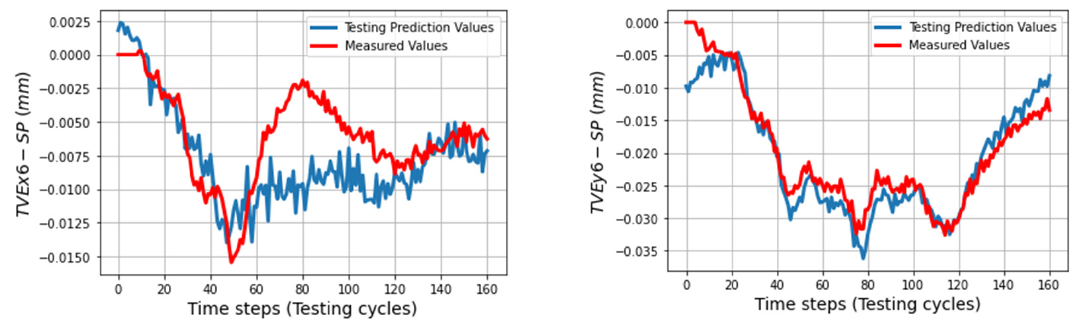
Figure 14. Prediction of TVEx6 and TVEy6 in the short process (SP) (1 cycle = 15 min).